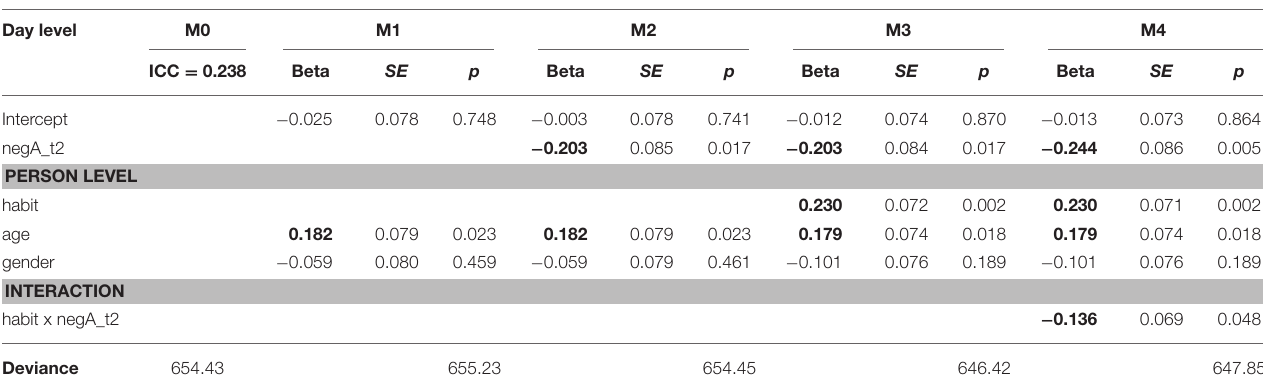
TABLE 2 | Model 1.2: Prediction of objective after work MVPA by negative affect and habit strength. Day